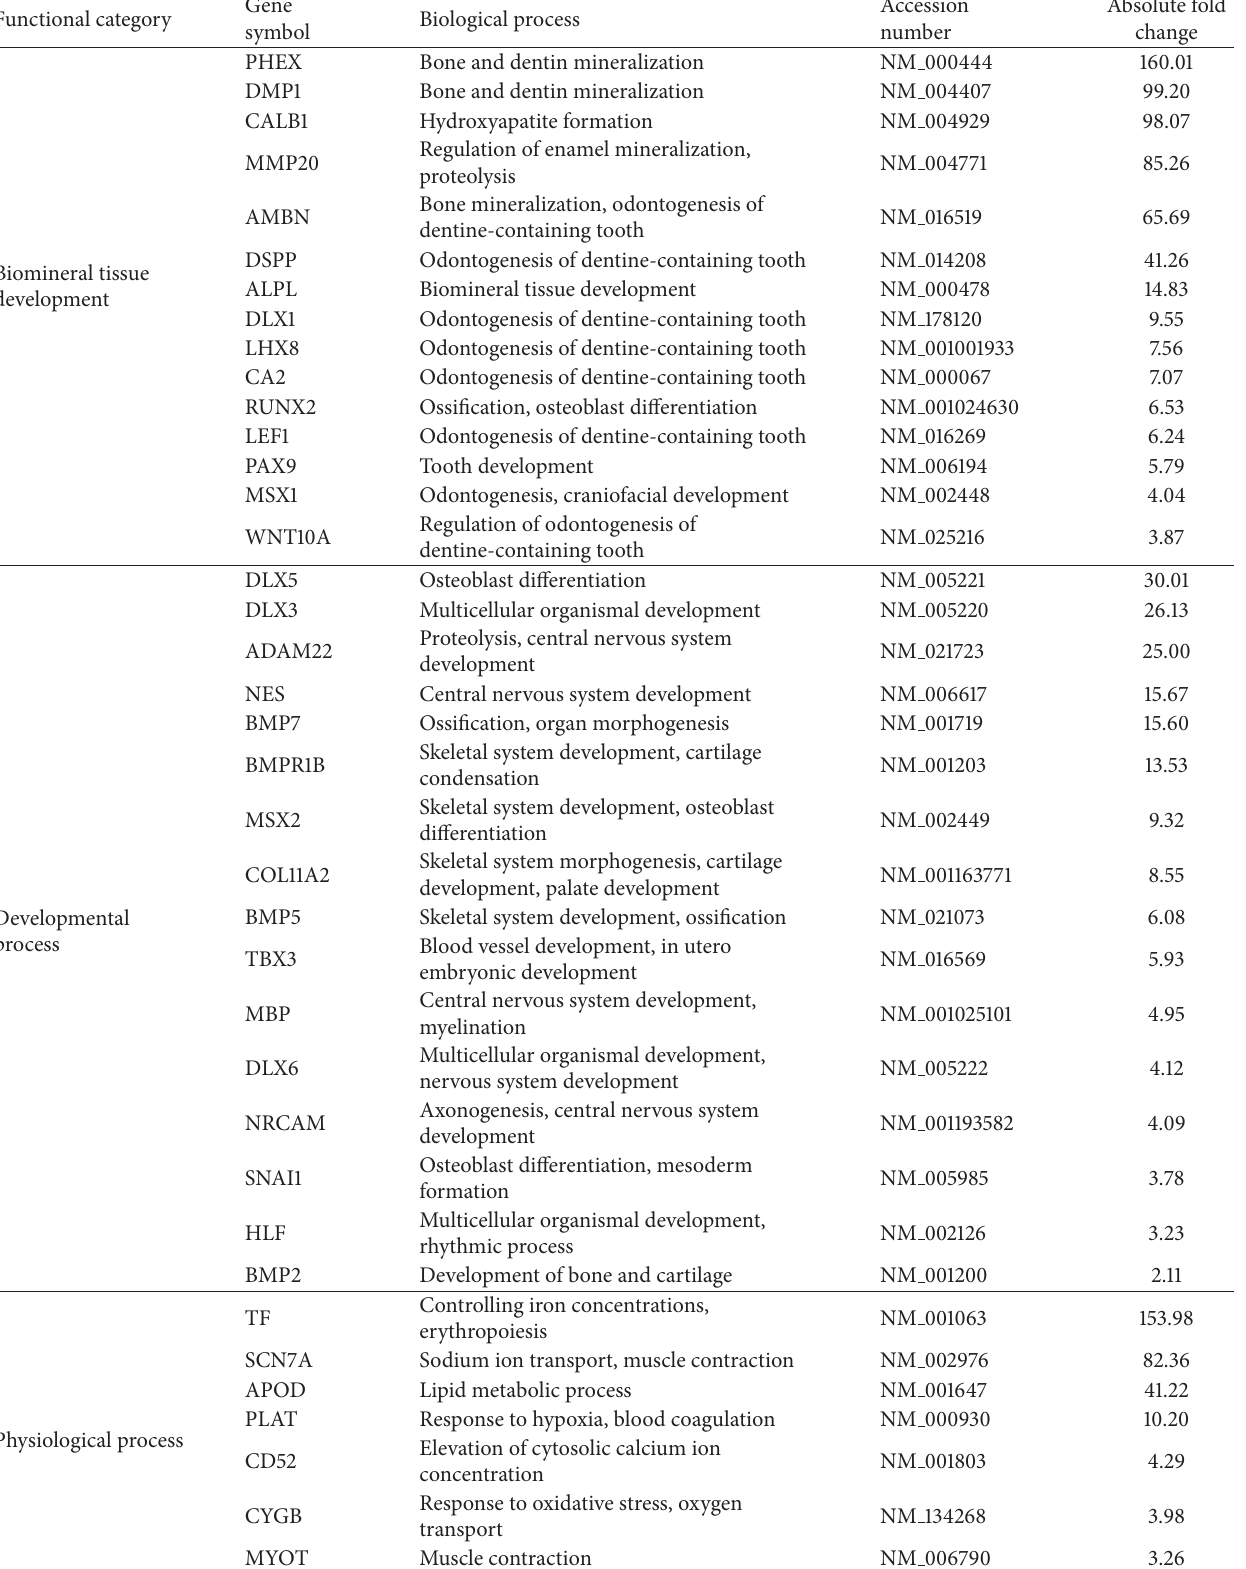
Table 3: Representative differentially expressed genes with higher expression levels in dental pulp tissue than in umbilical cord. Functional category